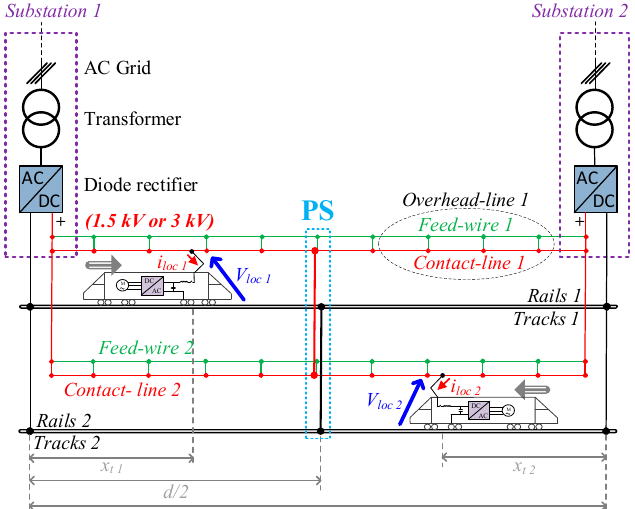
Figure 6. Classical DC railway electrification system: double-track line with paralleling station (PS) and contact line with parallel feed wire (overhead line).